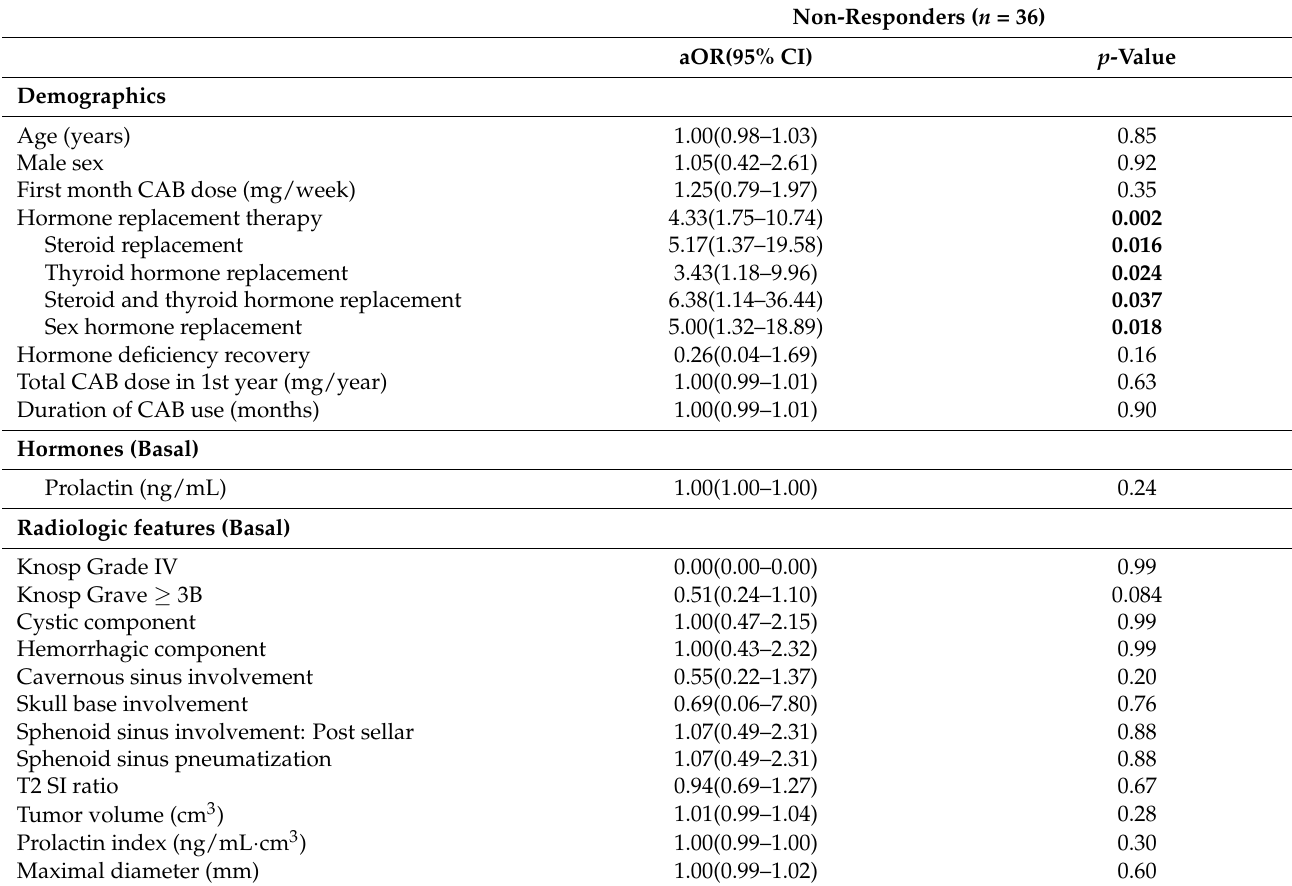
Table 4. Univariate logistic analysis for incidence of hormonal and radiologic non-responders in bioactive prolactinoma.